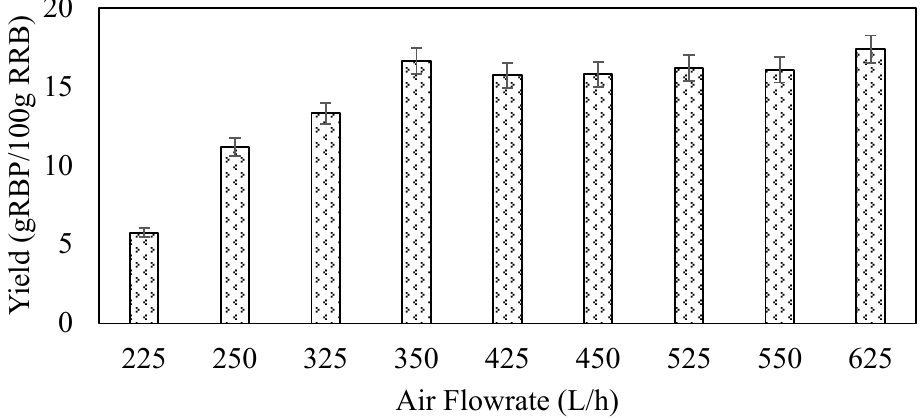
Figure 4. Effect of air flowrate on the Rice Bran Protein (RBP) powder yield at the constant inlet temperature of 160 °C and feed flowrate of 20%.